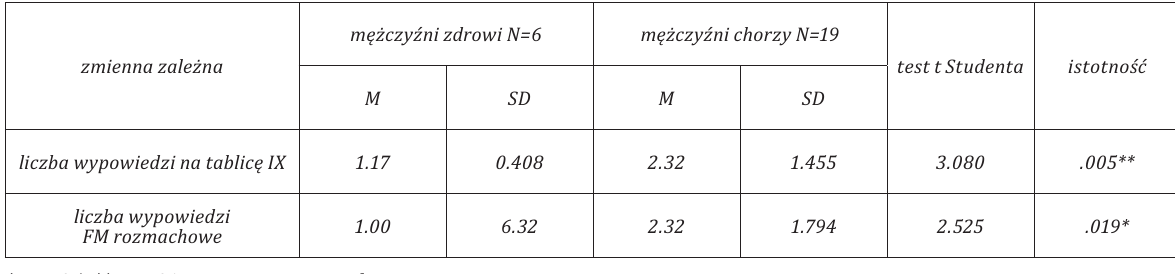
w Tabeli 3. Tabela 3. Różnice i ich istotności między grupą zdrowych mężczyzn a grupą chorych mężczyzn w wybranych